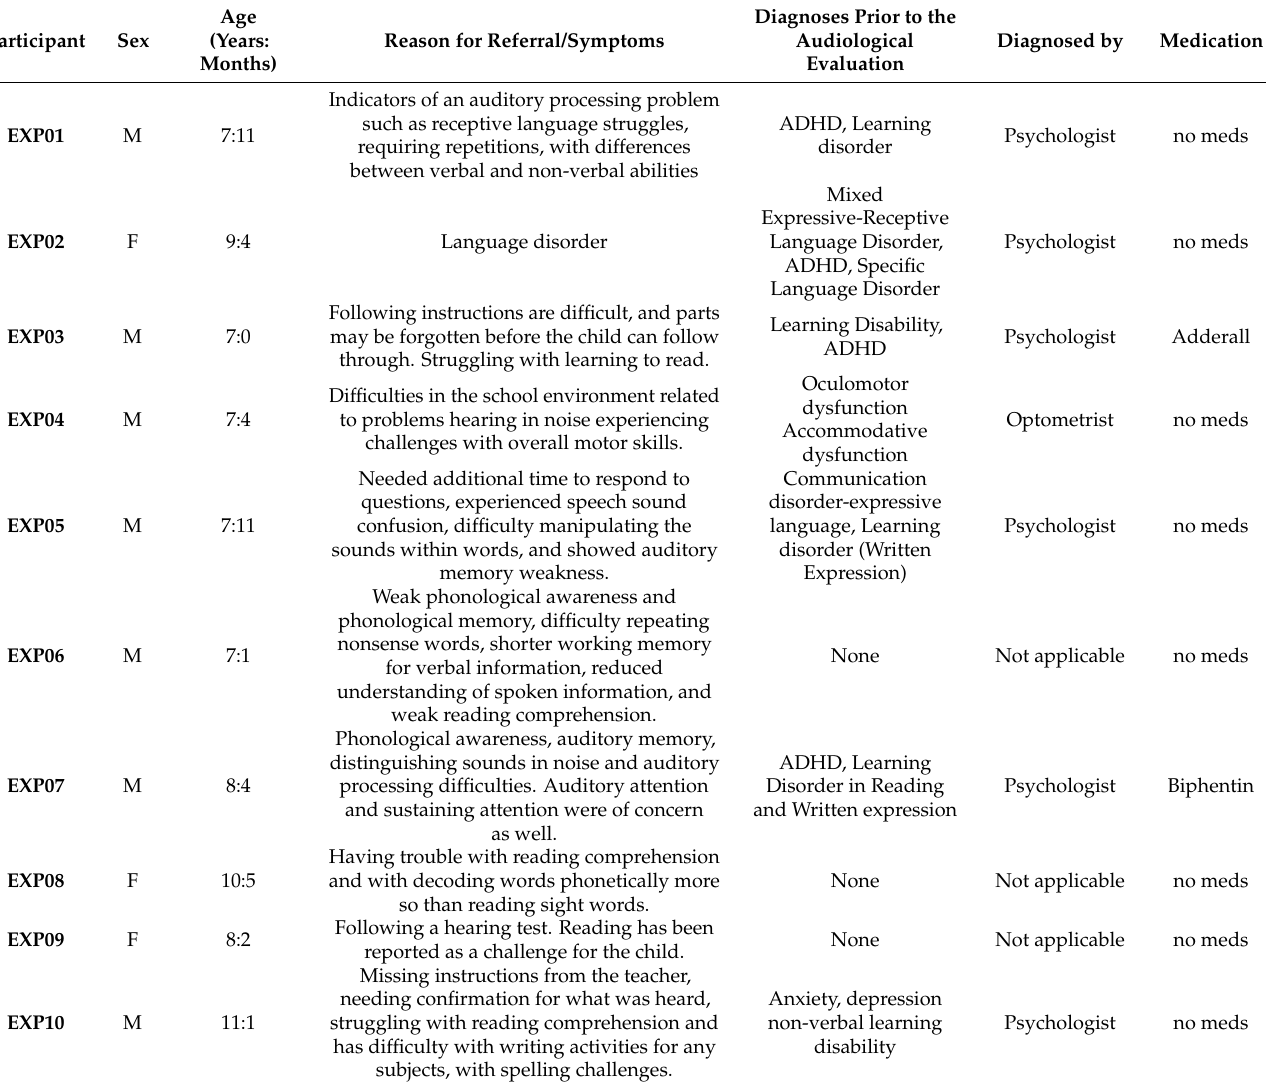
Table 1. Profile of the ten children in the experimental